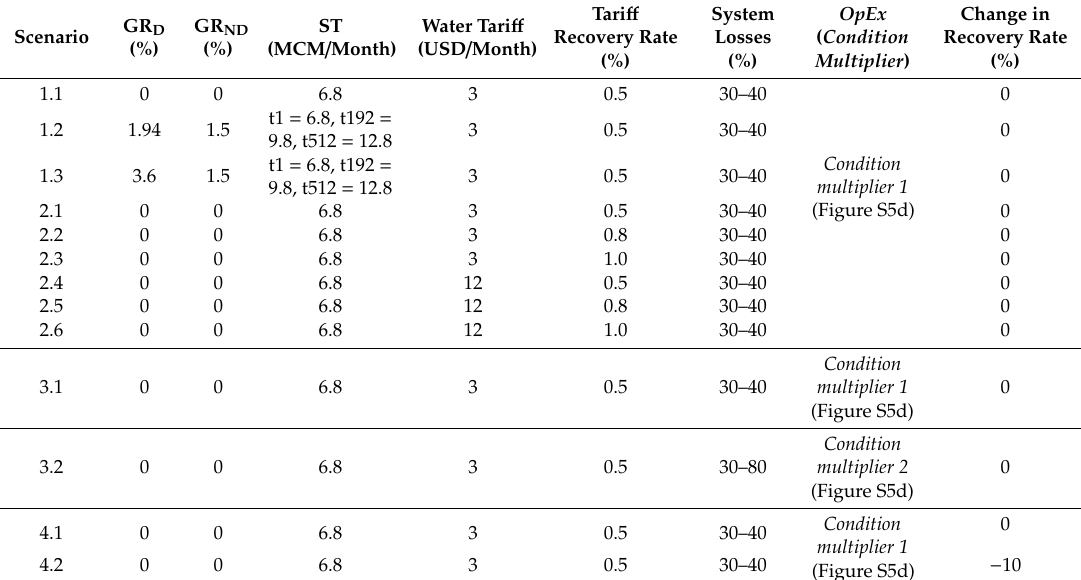
Table 1. Summary of scenario conditions for sensitivity